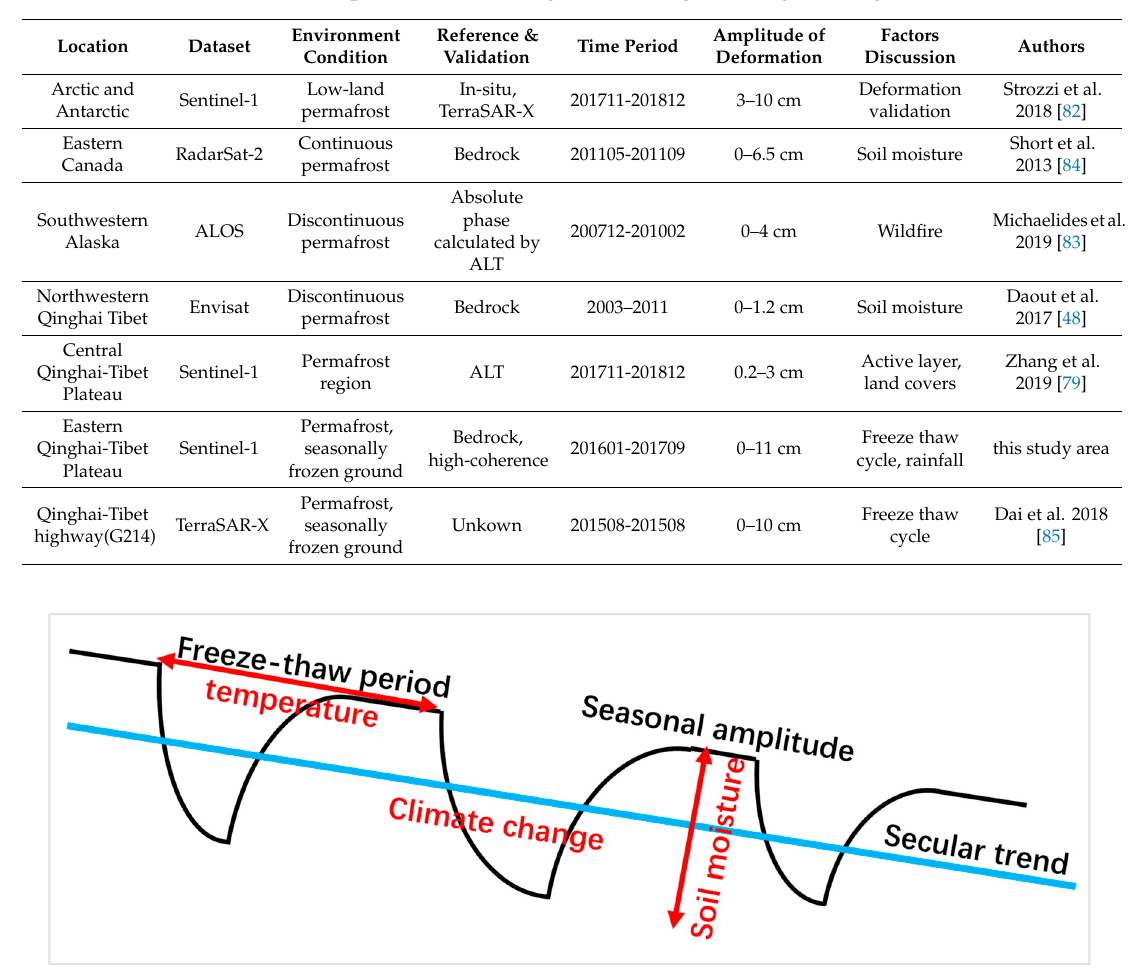
Figure 9. Deformation decomposed into seasonal (e.g., freeze thaw period) and secular trend (e.g., climate change) in permafrost regions. Modified from Michaelides et al. 2019 [83]. The period was controlled by the temperature, while the amplitude was determined by the soil moisture.